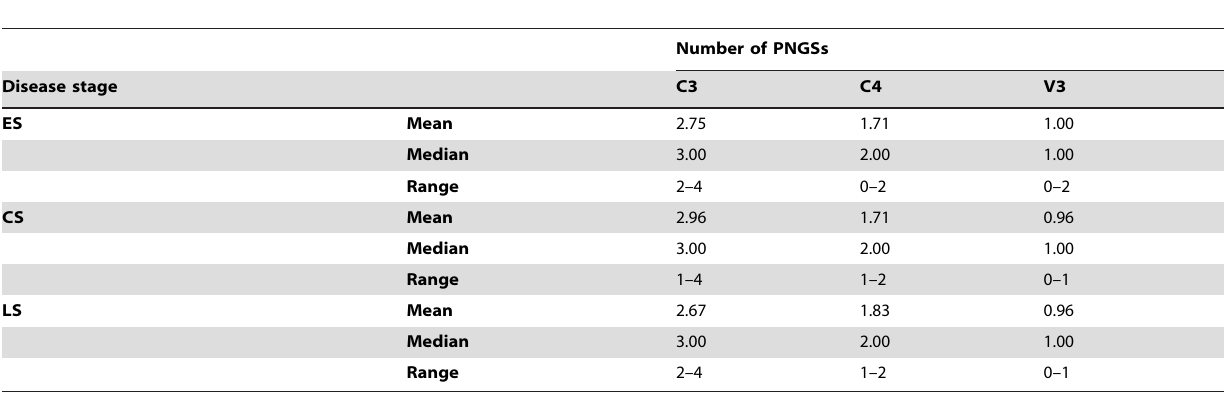
Table 2. Number of PNGSs in gp120 V3, C3 and C4 regions of HIV-1 clade C variants from patients at different disease stages.